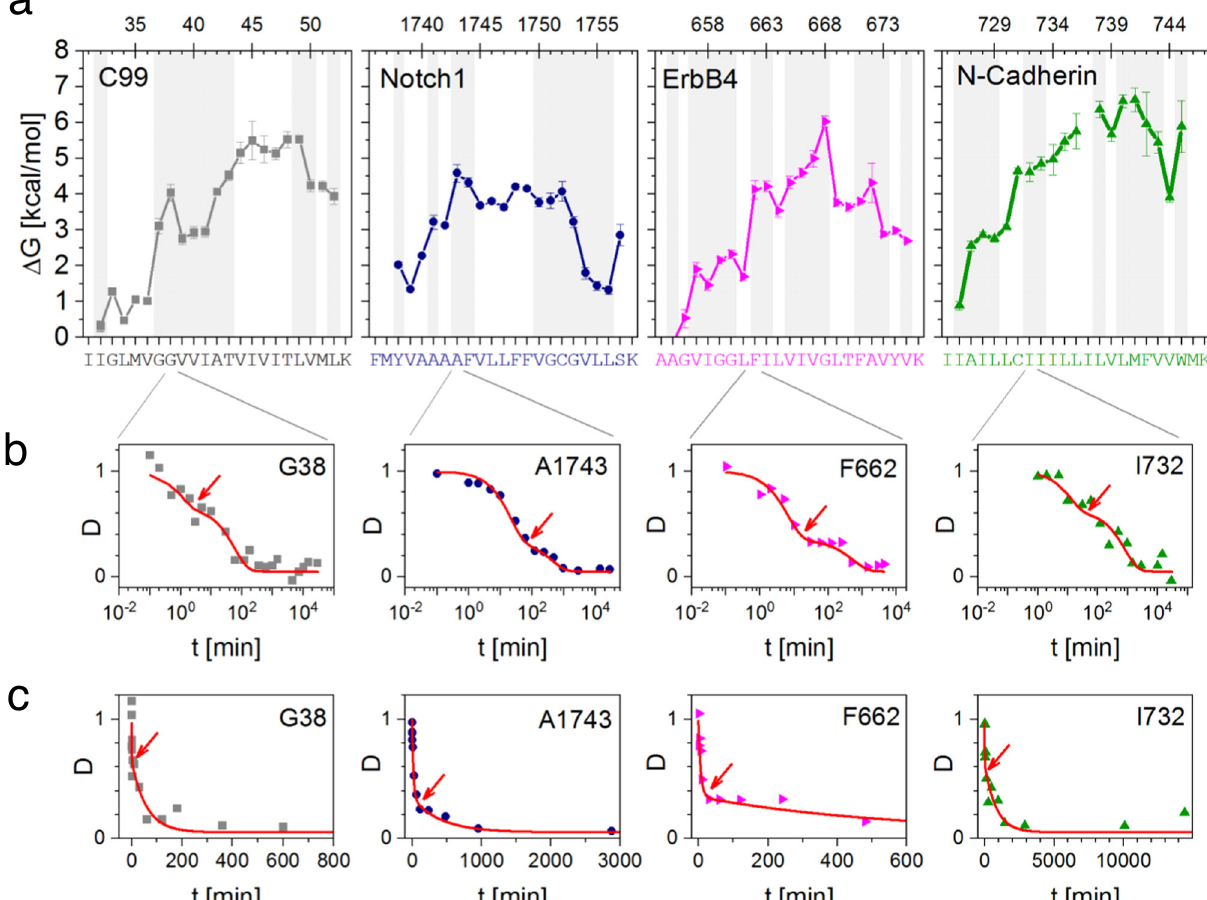
Fig. 2 Comparing helix fl exibilities of various γ -secretase substrate TMDs. a Comparison of amide H-bond stabilities Δ G calculated from k exp values given in Supplementary Fig 1. Areas of biphasic DHX are shaded. Sequence positions are given above the graphics (A β numbering is used for C99) and the complete TMD peptide sequences are given in Supplementary Table 1. No values can be shown for N-Cadherin I737 due to poor fragmentation ef fi ciency and/or overlap of isobaric fragments. Error bars correspond to standard con fi dence intervals (calculated from the errors of fi t in k exp determination, in some cases smaller than the symbols, N = 3 independent DHX reactions). b , c Exemplary DHX kinetics that is fi tted with a biexponential decay function at a logarithmic b or linear c scale. Note that linear time axes are truncated such as to better visualize the intersections between fast and slow regimes of exchange (arrows). Data are reproduced from Supplementary Fig